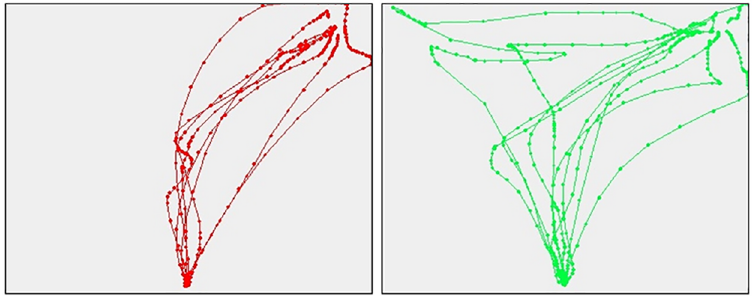
Fig 3. Prototypical trajectoryof a liar. Responses of a liar (subject 2) to control (red) and unexpected questions(green).